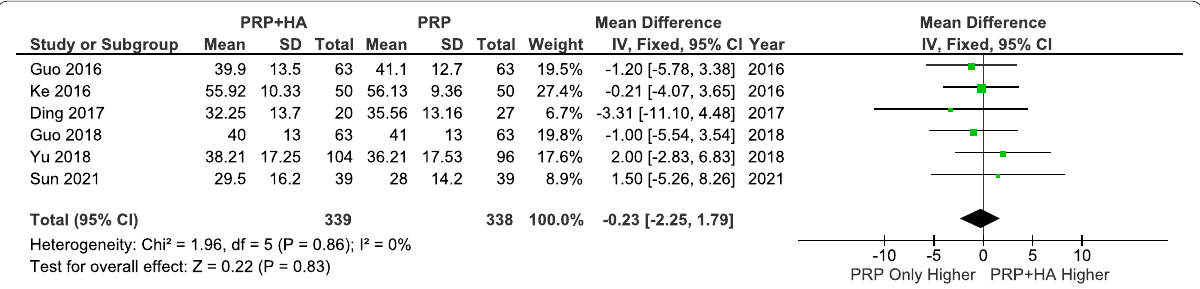
HA and PRP at baseline +